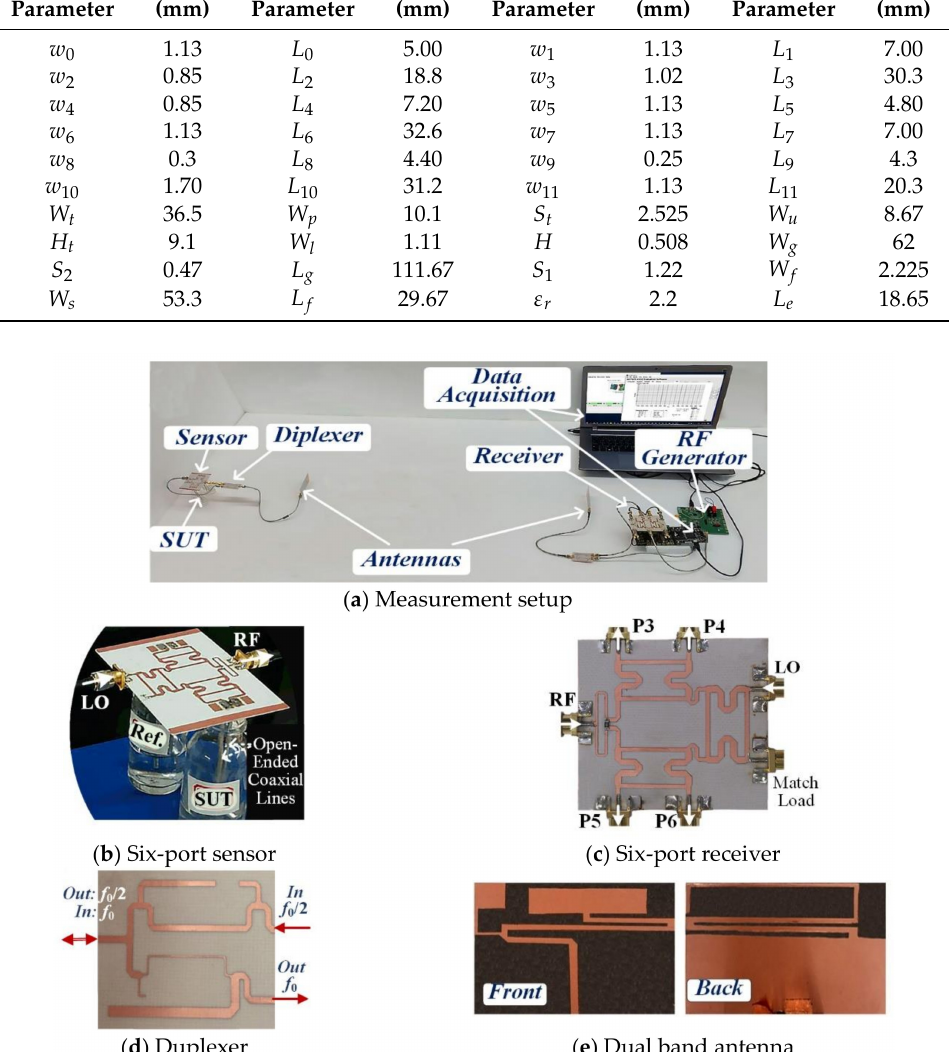
Figure 4. Fabricated water quality sensing system.